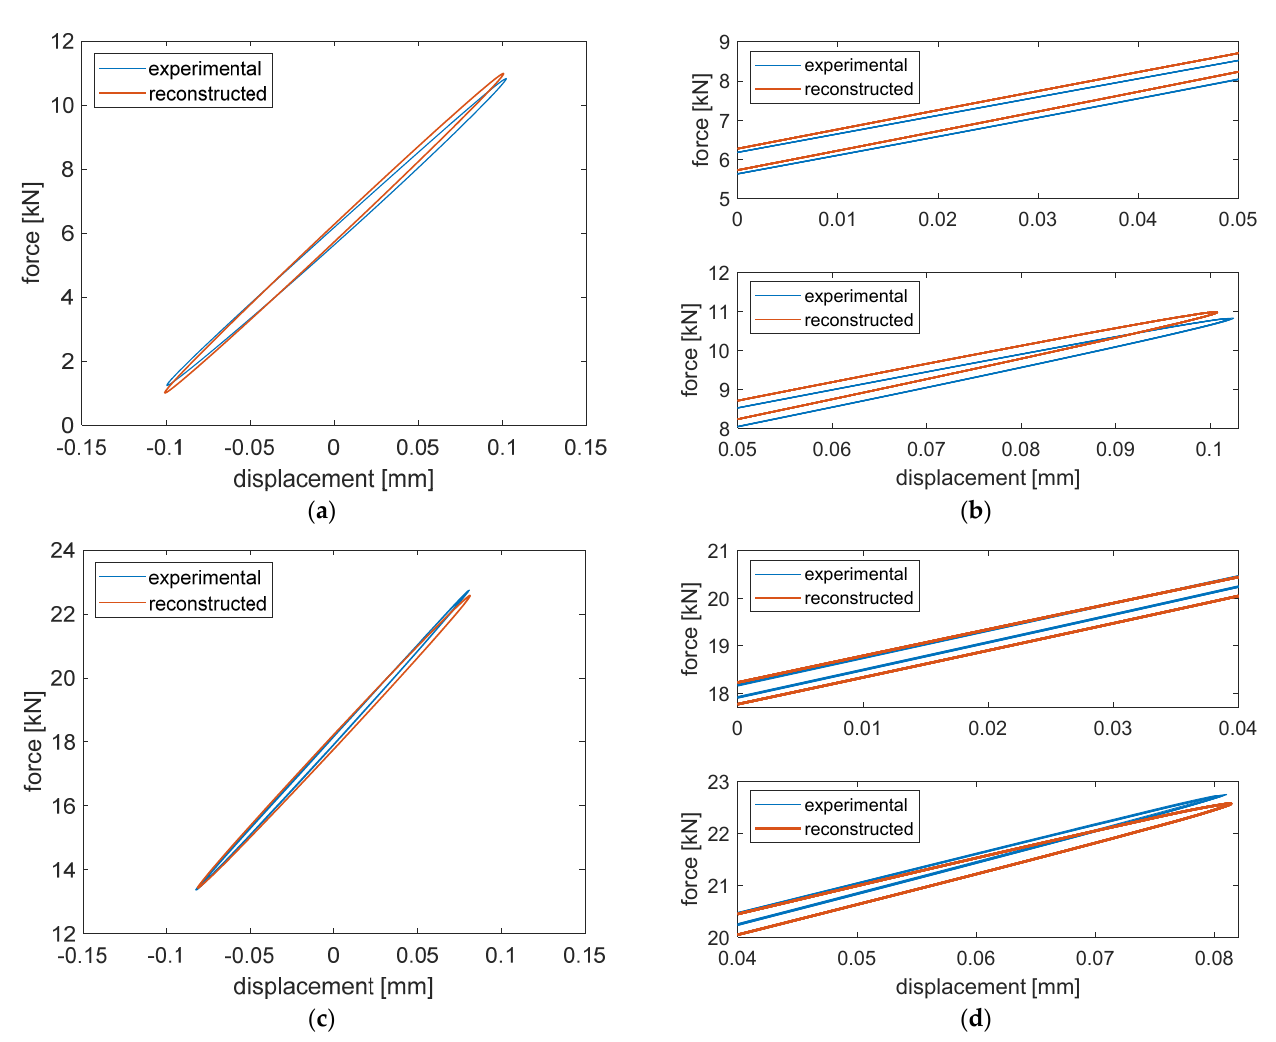
Figure 5. Example of force–displacement cycles with applied mono-harmonic force: ( a ) mono-harmonic force at 1 Hz with preload of 6 kN, full cycle; ( b ) mono-harmonic force at 1 Hz with preload of 6 kN, detailed presentations in the displacement range of 0 ÷ 0.05 mm (upper plot) and 0.05 ÷ 0.1 mm (lower plot); ( c ) mono-harmonic force at 5 Hz with preload of 18 kN, full cycle; ( d ) mono-harmonic force at 5 Hz with preload of 18 kN, detailed presentations in the displacement range of 0 ÷ 0.04 mm (upper plot) and 0.04 ÷ 0.08 mm (lower plot). Both tests are performed with a dynamical amplitude of 5 kN.